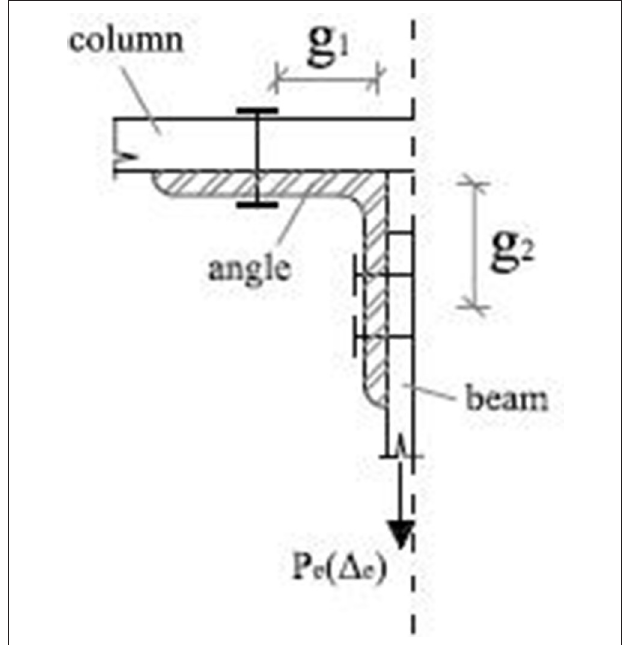
FIGURE 3 | Analytical solution of semi-rigid angle connection, figure based on Lee and Moon (2002).